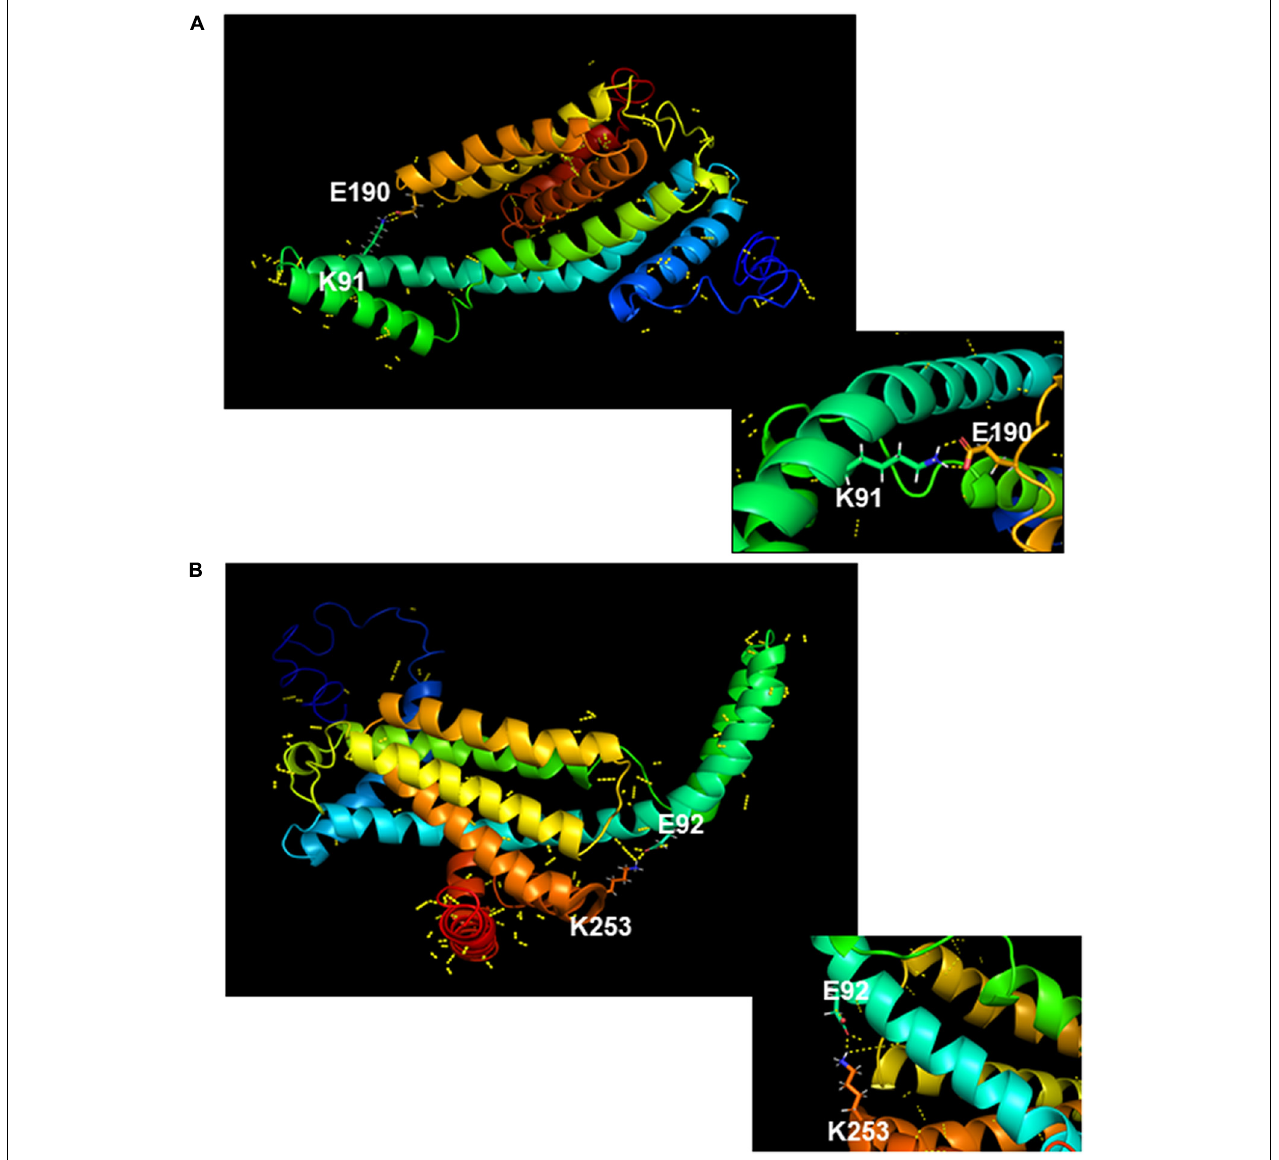
FIGURE 7 | In silico modeling of salt bridge formation between cytoplasmic domains of YidC1 or YidC2. (A) Putative polar contacts on the side chains of YidC1 (yellow) were mapped and displayed using the Pymol Plugin. The salt bridge between residues K91 and E190 is shown enlarged in the box. (B) Putative polar contacts on the side chains of YidC2 (yellow) were mapped and displayed using the Pymol Plugin. The salt bridge between residues E92 and K253 is shown enlarged in the